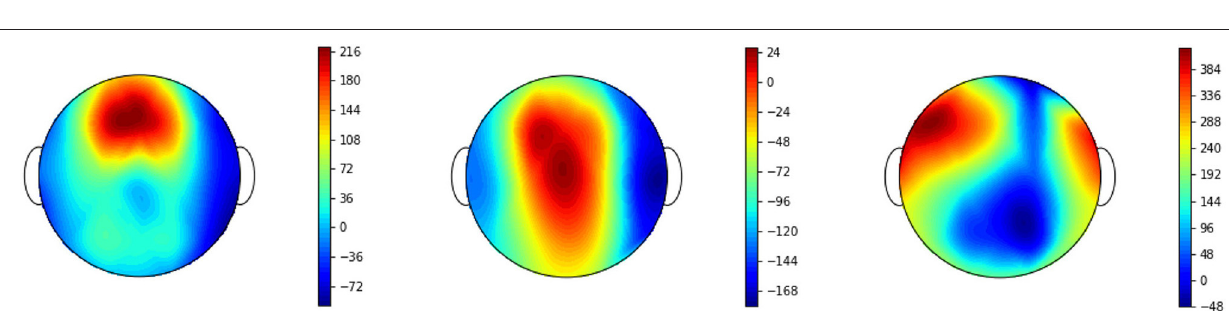
FIGURE 5 | Potential field maps representing the vectors of the calculated pseudoinverse.